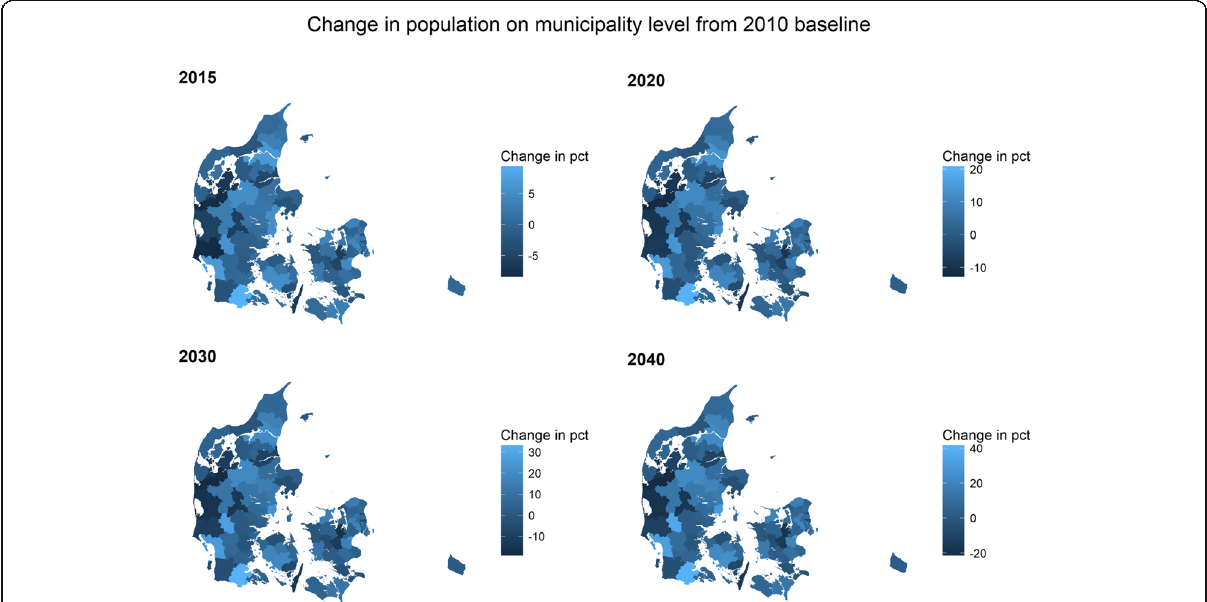
Fig. 1 Illustration of the urbanisation trend in